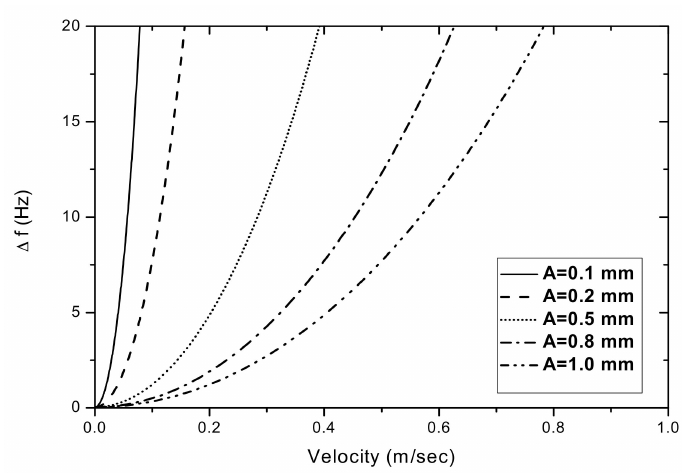
Figure 6. ∆ f as a function of V 0 for various vibration amplitudes